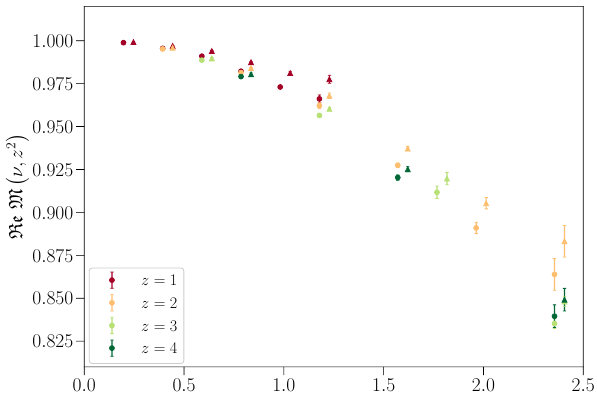
(cid:0) (cid:1) and discretization corrected Re M 0 (cid:0) ν, z 2